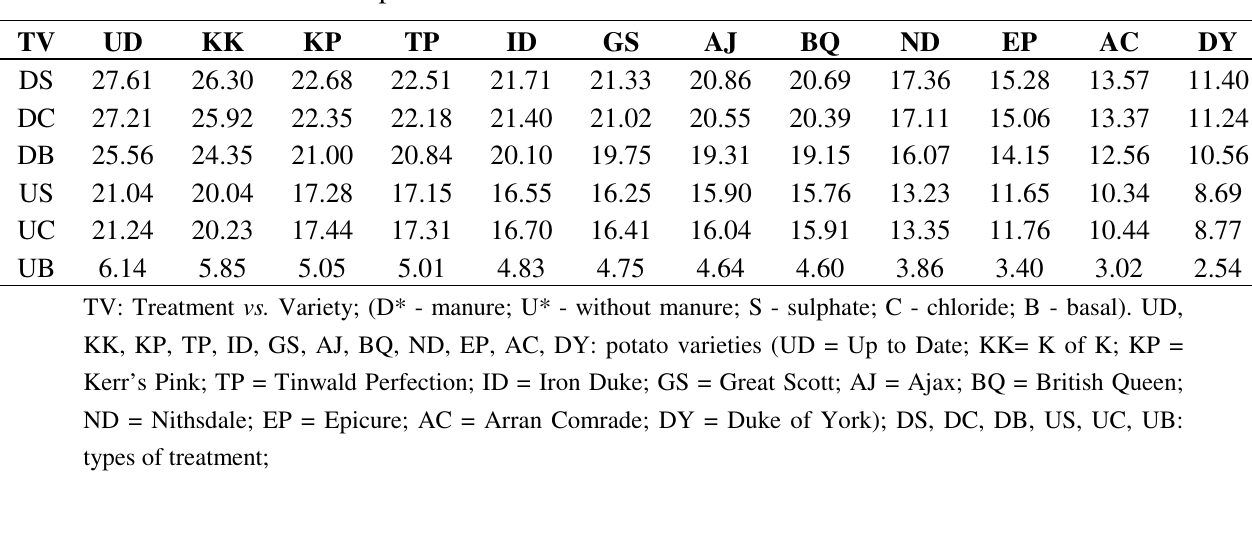
b ) calculated with Equation (12) for the response to i j 1 ≤ i ≤ 6; 1 ≤ j ≤ 12